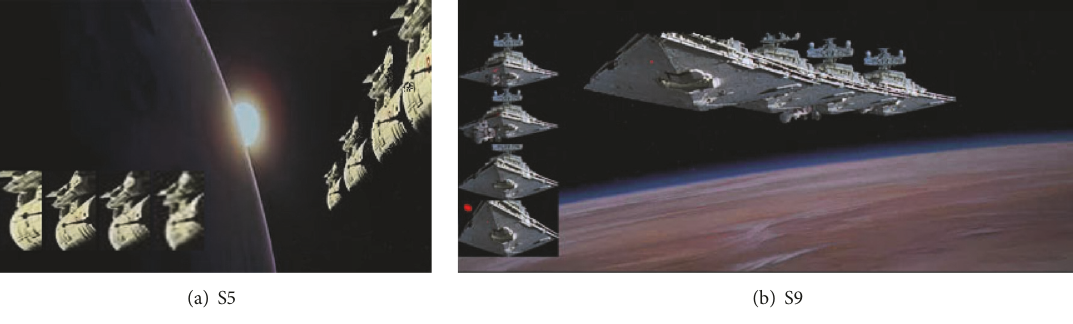
Figure 16: Space transcale display of space image